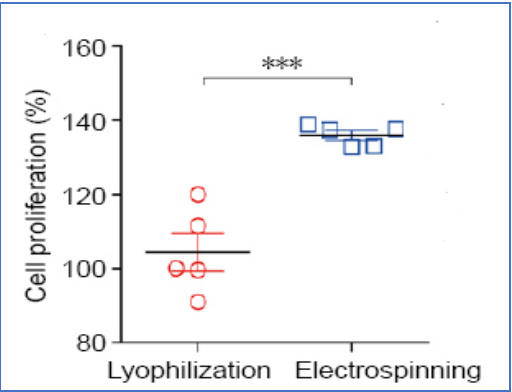
Figure 7. Comparison of the proliferation rate of Schwann cells on the electrospun chitosan scaffold vs. lyophilized chitosan scaffold. Adapted with permission [137].